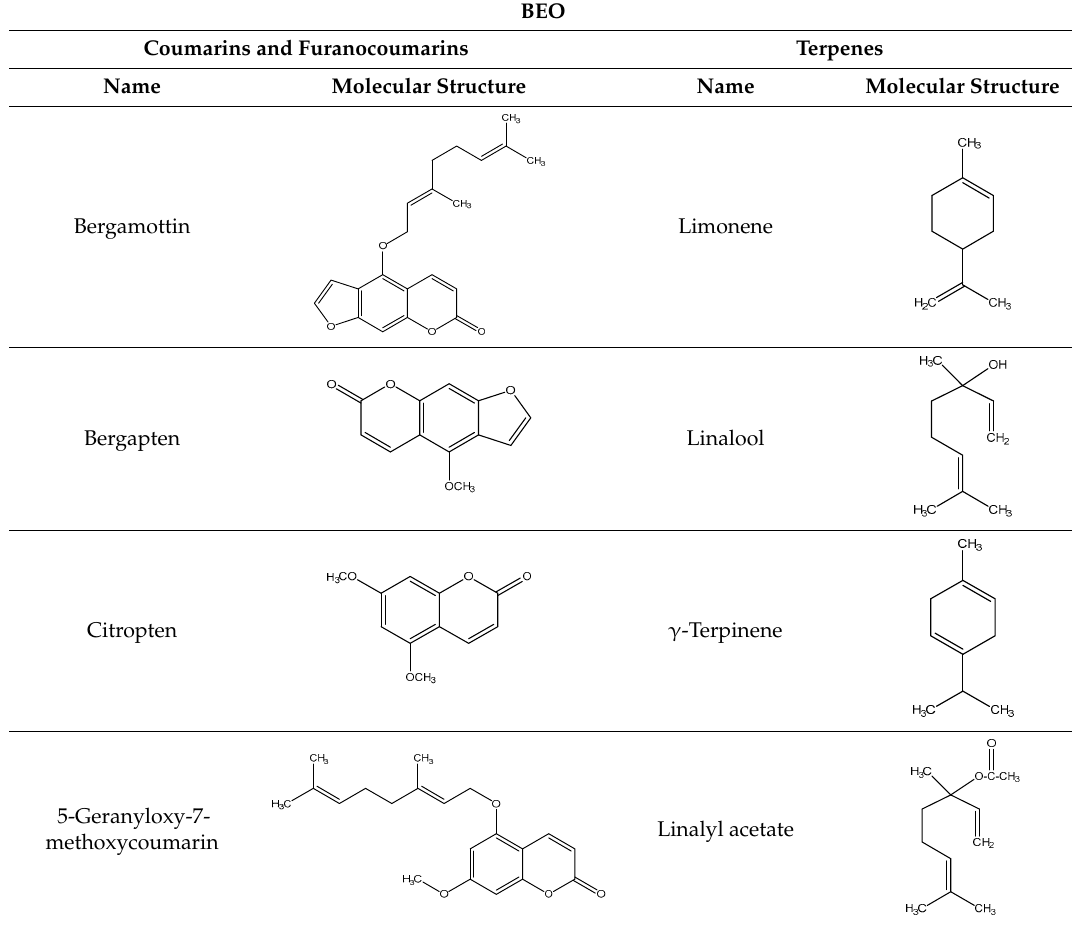
Table 1. The main constituents of BEO and their chemical structures.